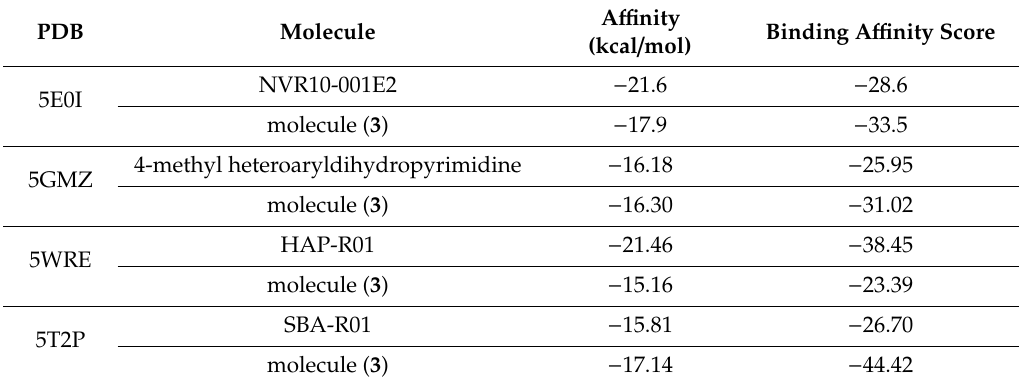
Table 3. Parameters of the binding a ffi nity of the title molecule ( 3 ) for a site on the D chains. A ffi nity Binding A ffi nity Score PDB Molecule (kcal / mol) NVR10-001E2 − 21.6 − 28.6 5E0I 4-methyl heteroaryldihydropyrimidine